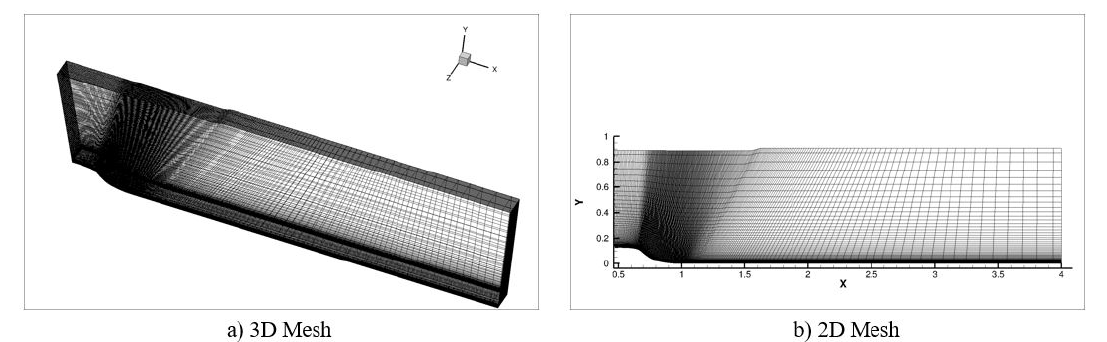
Figure 4. Two-dimensional geometry.